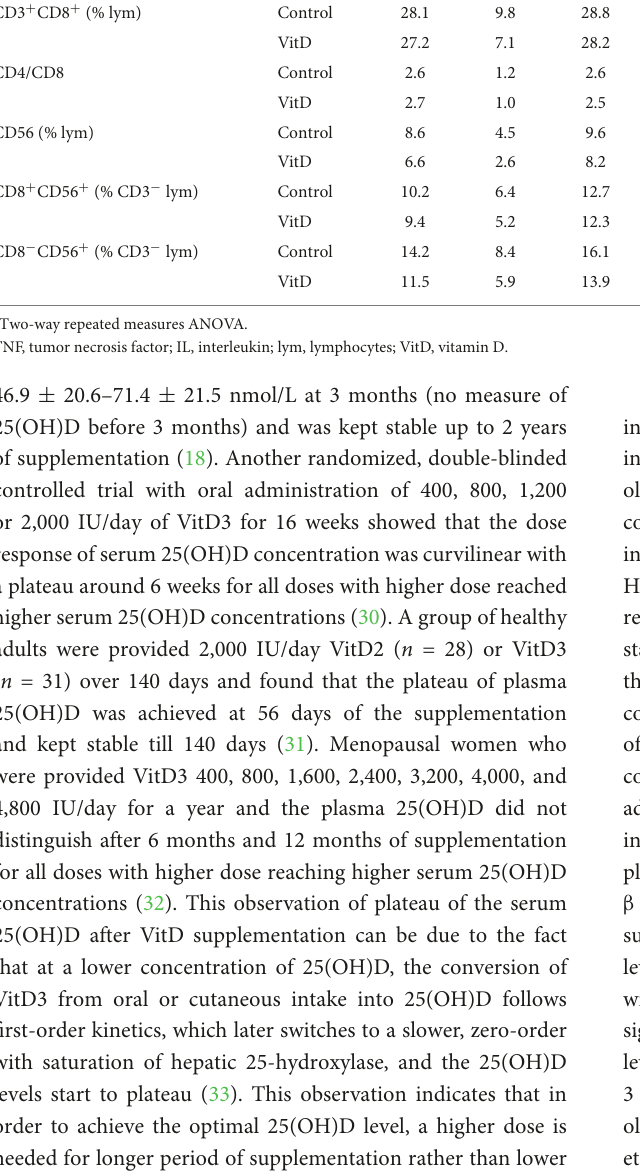
VitD3 from oral or cutaneous intake into 25(OH)D follows first-order kinetics, which later switches to a slower, zero-order with saturation of hepatic 25-hydroxylase, and the 25(OH)D levels start to plateau (33). This observation indicates that in order to achieve the optimal 25(OH)D level, a higher dose is needed for longer period of supplementation rather than lower dose but prolonged period of